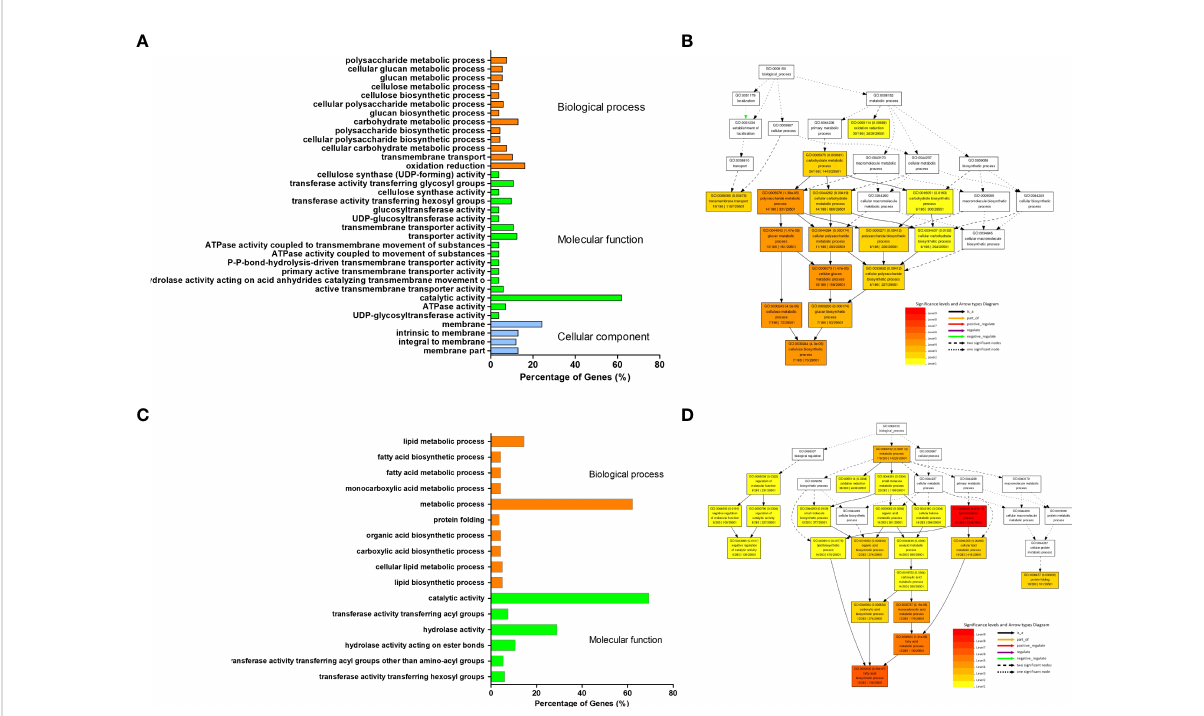
FIGURE 4 Categorization of differentially expressed genes between dwarf mutant and control. (A, C) GO enriched categories of up- and down-regulated DEGs, respectively. 470 out of 686 input genes were annotated with GO terms. (B, D) Directed acyclic graph (DAG) of biological process enriched by GO analysis of up- and down-regulated DEGs, respectively. DAG of the biological processes was reconstructed using top 10 enriched GO categories; the signi fi cant level of each category was labelled on map, each node for a GO term, and the color represents enrichment degree, the darker the higher enrichment.